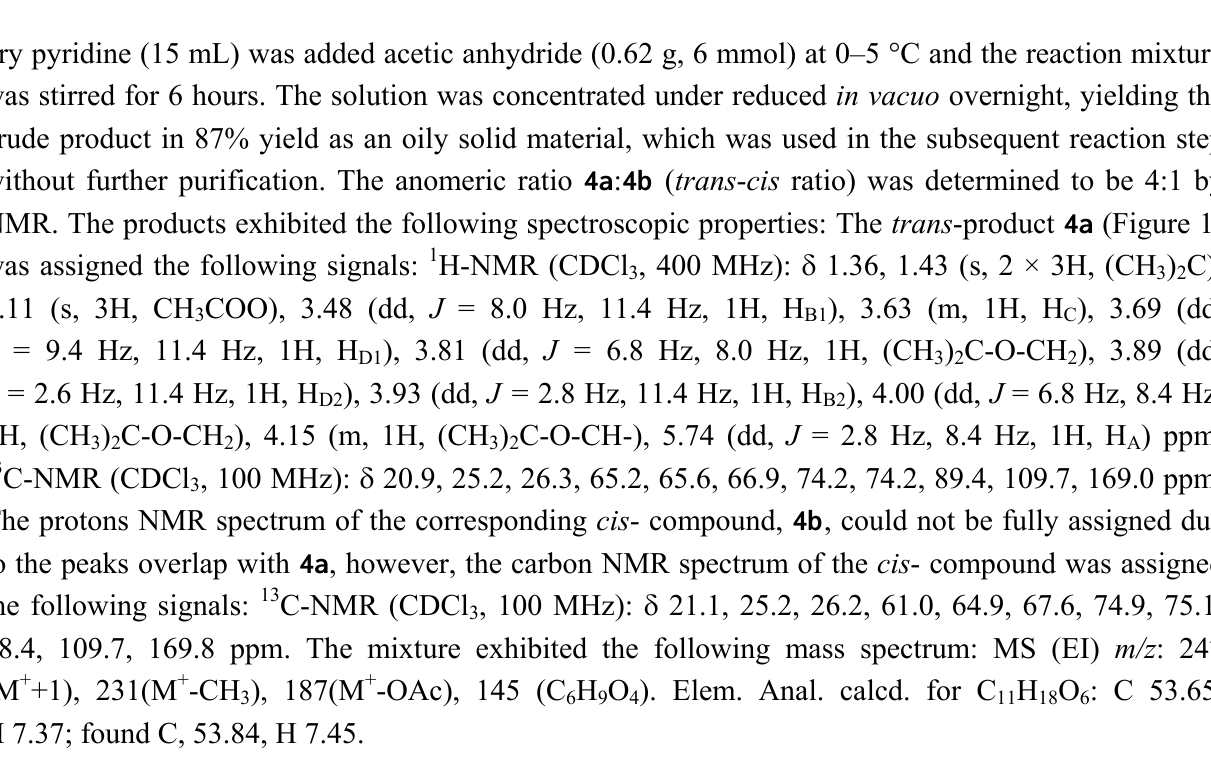
Figure 1. Structure of compound 4a